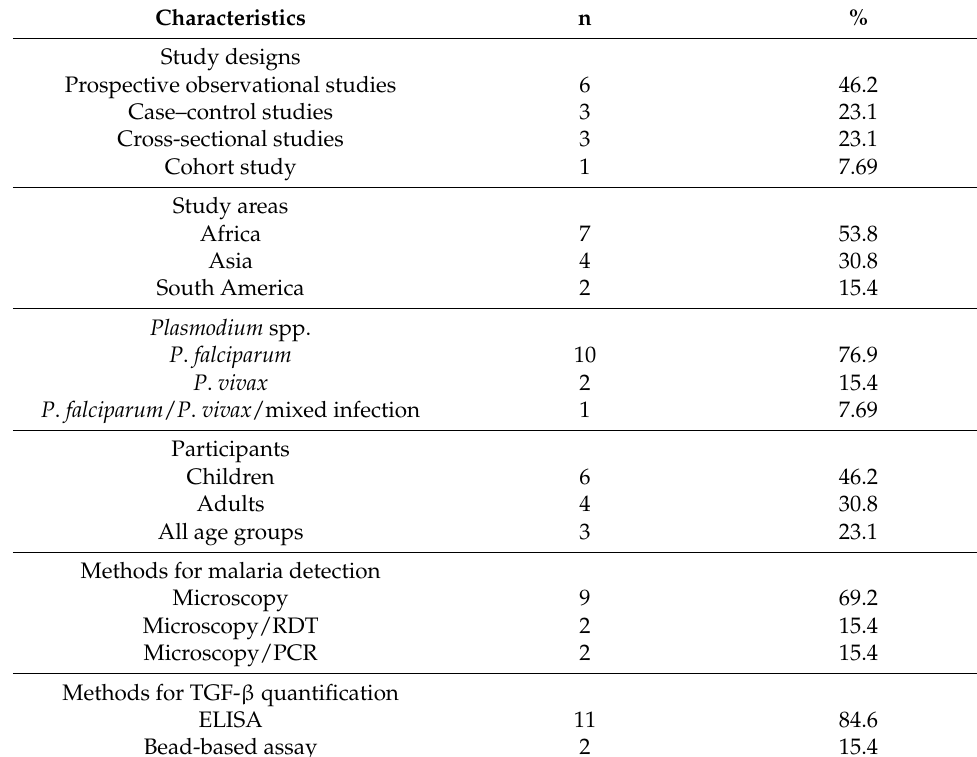
Table 1. Characteristics of the included studies.